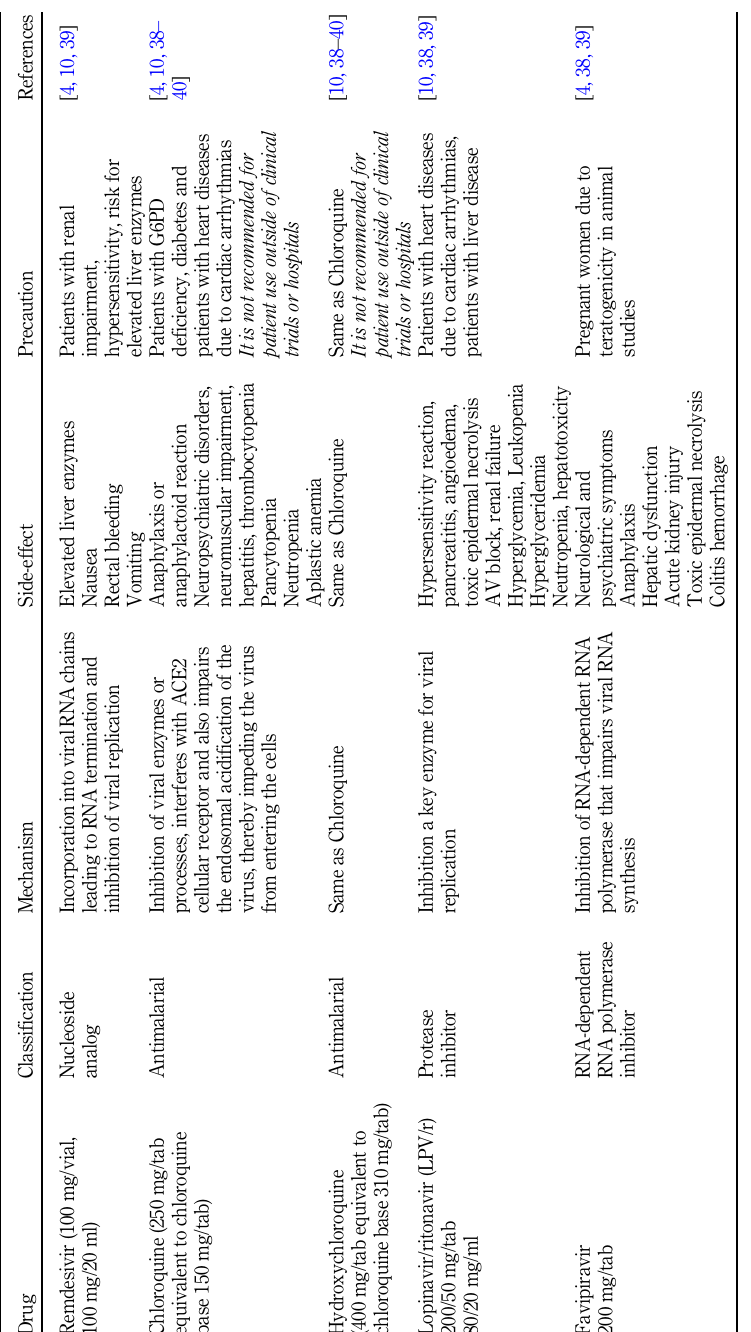
Table 2. Potential antimicrobial drugs for the treatment of Covid-19 [4,